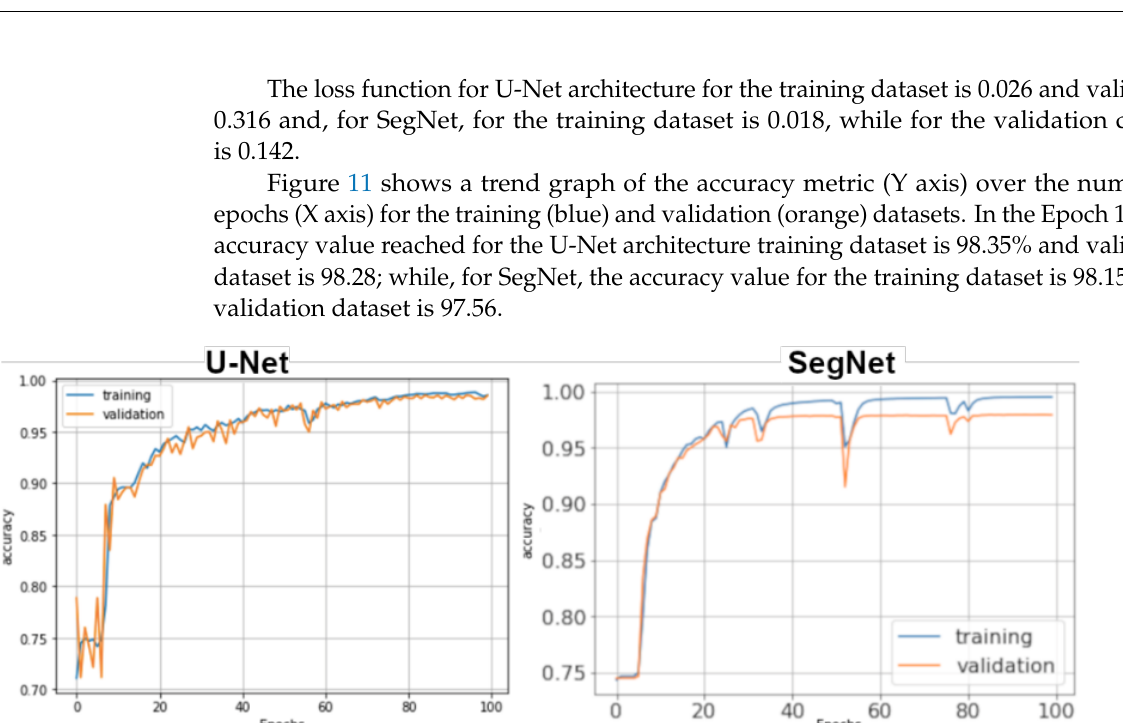
Figure 11. Trend curve of accuracy metric of training and validation dataset.